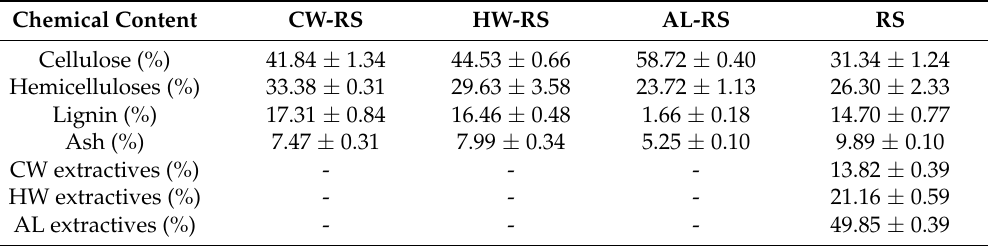
Table 1. Main chemical compositions of the unextracted and extracted rice